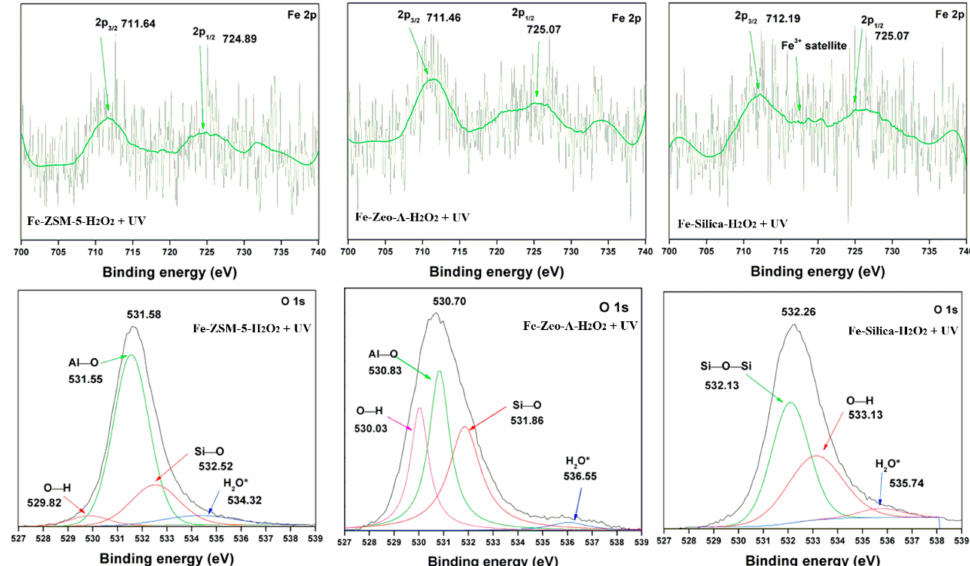
Figure 12. HRXPS Fe 2p and deconvoluted O 1 s spectra of Fe-ZSM-5, Fe-Zeo-A, and Fe-Silica after phenol degradation with H 2 O 2 + UV.